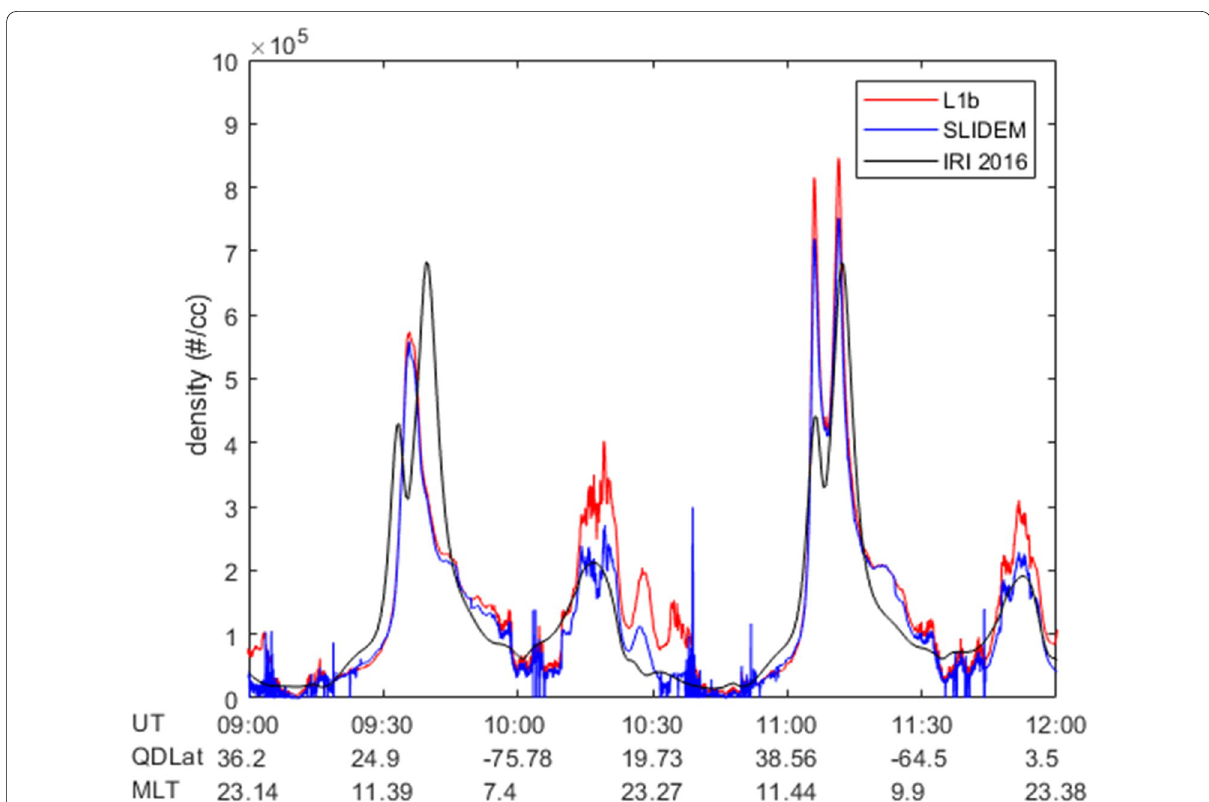
Fig. 2 Swarm A density estimations for 1 January 2018, using the SLIDEM methodology, the existing Level 1b estimate, and an independent measurement from IRI-2016